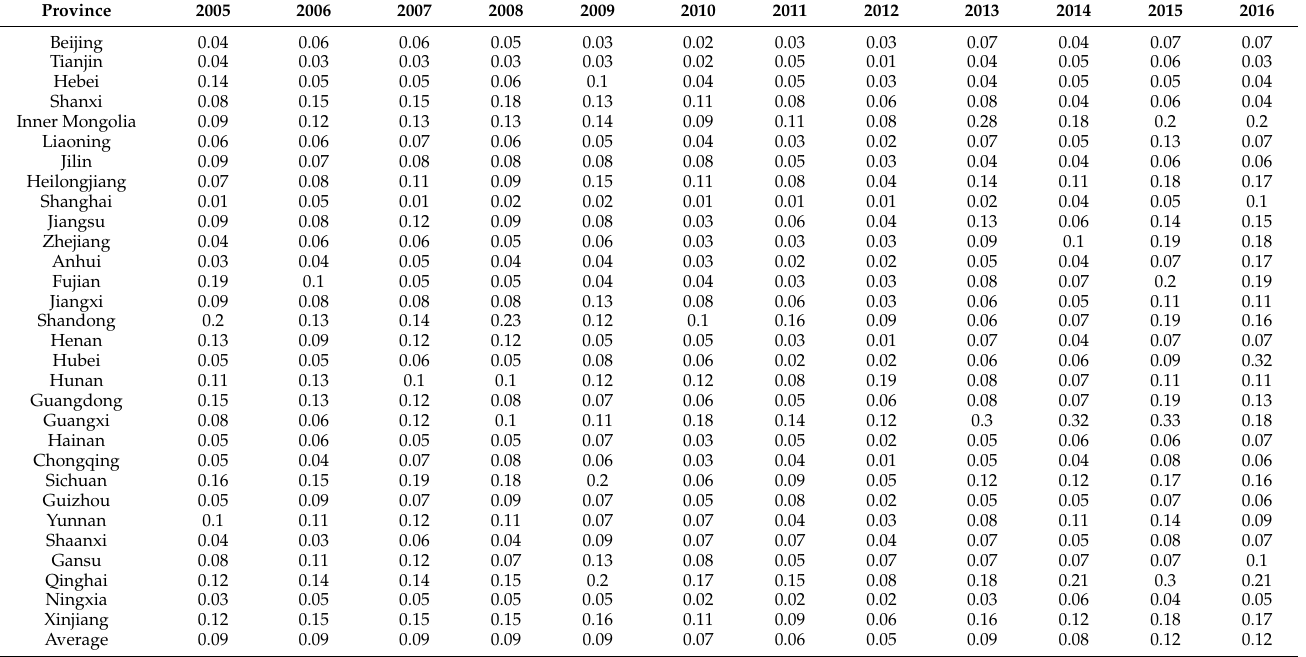
Table 3. The comprehensive development levels of ecological